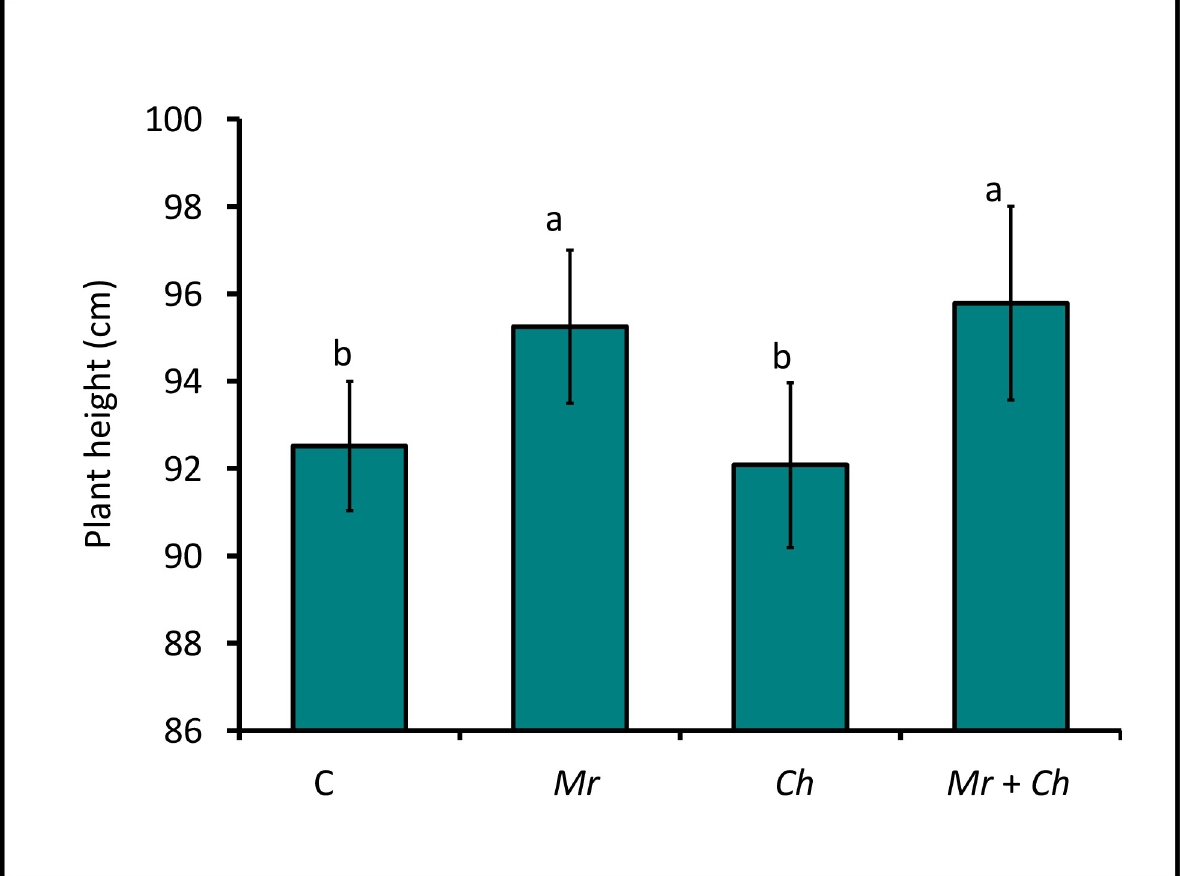
Fig 1. Mean height of V4 maize. End-of-experiment height of maize in M . robertsii (Mr), C . heterostrophus (Ch), M . robertsii + C . heterostrophus (Mr + Ch) treatments and untreated control (C) ( F 3,129 = 3.05; P = 0.03). Values are untransformed means ± standard error of the mean (SEM); different letters indicate significant differences at α =